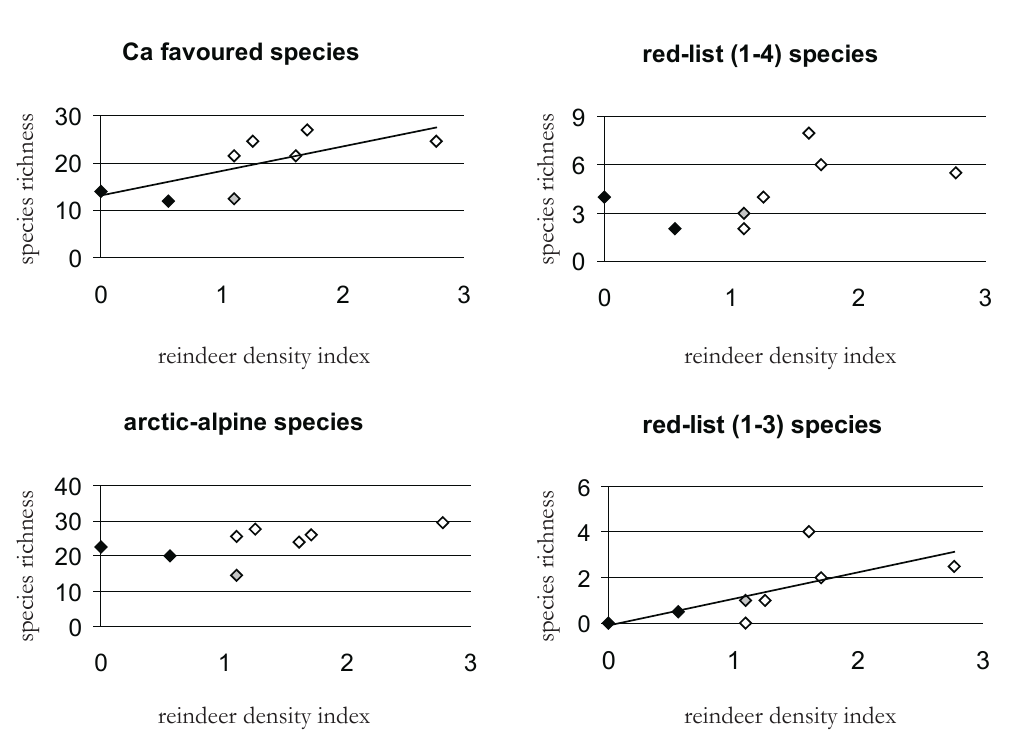
Fig. 5. Relationship between reindeer density and richness of arctic and alpine, Ca favored and red listed plants. The two sites inside Malla Reserve are marked with black squares and Saana is marked with gray squares.